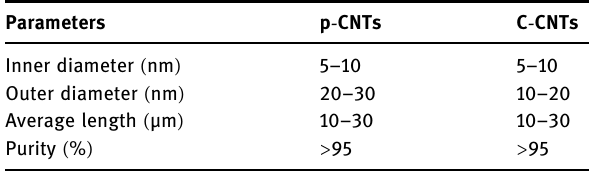
Table 1: Parameters for p - CNTs and C -